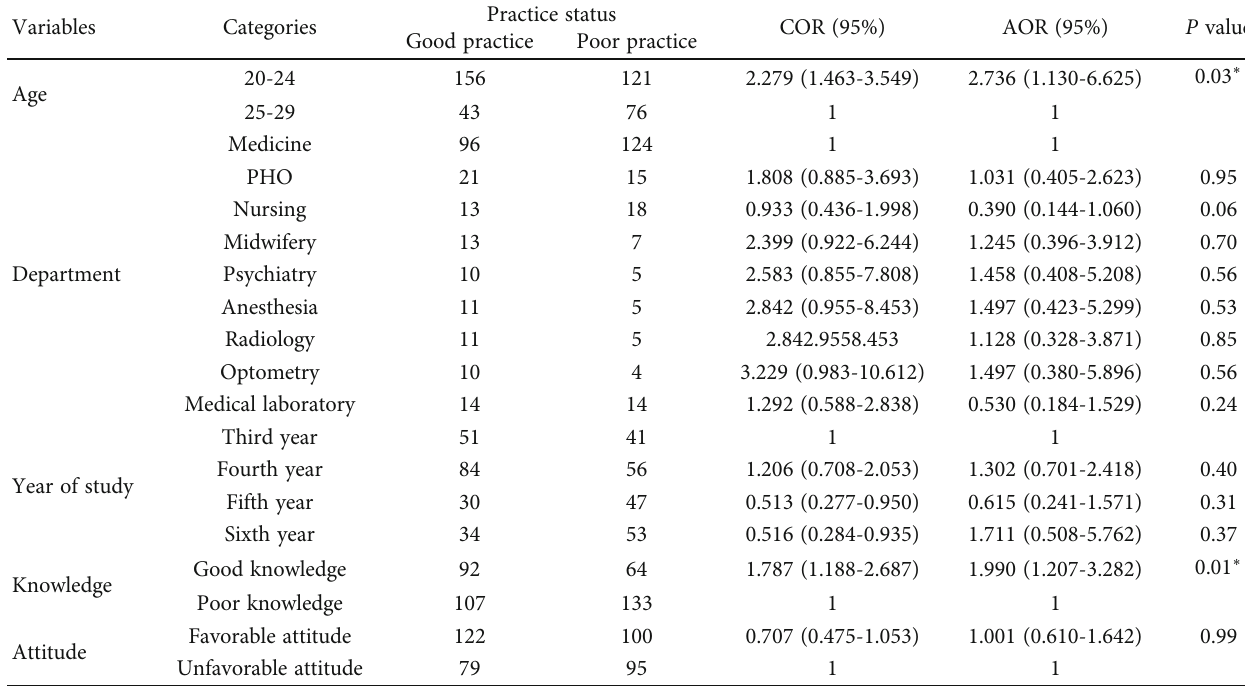
Table 6: Bivariate and multivariate analysis of factors associated with practice towards HBV infection prevention among students ’ at HUCMHS, Hawassa, Sidama, Ethiopia,